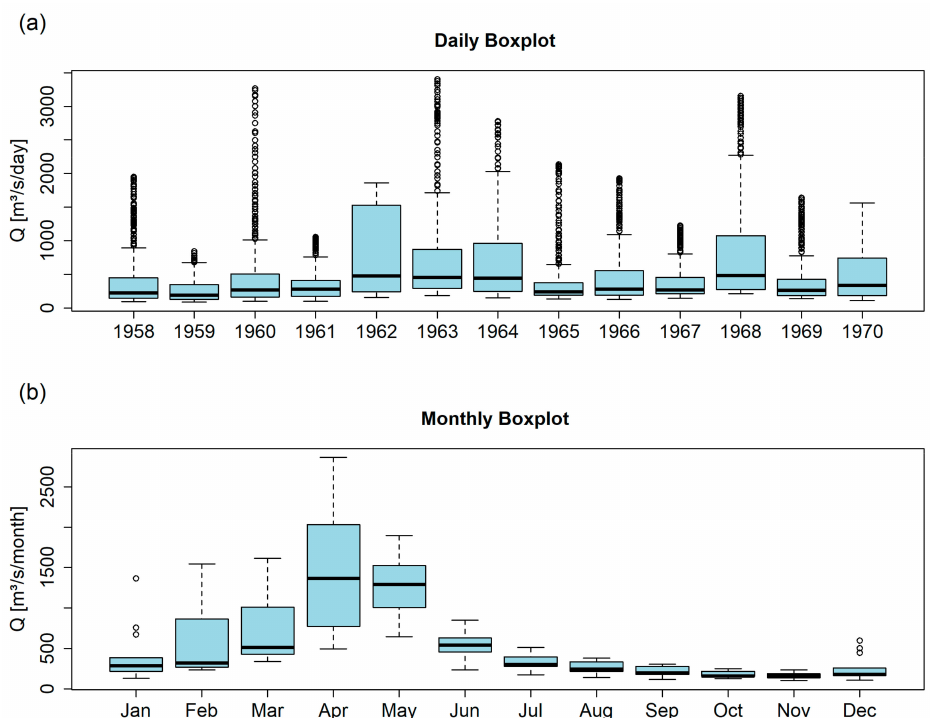
Figure 8. Boxplots for discharge on ( a ) daily and ( b ) monthly resolution, emphasizing the variation of discharge on different timescales and the distinction of wet and dry season.